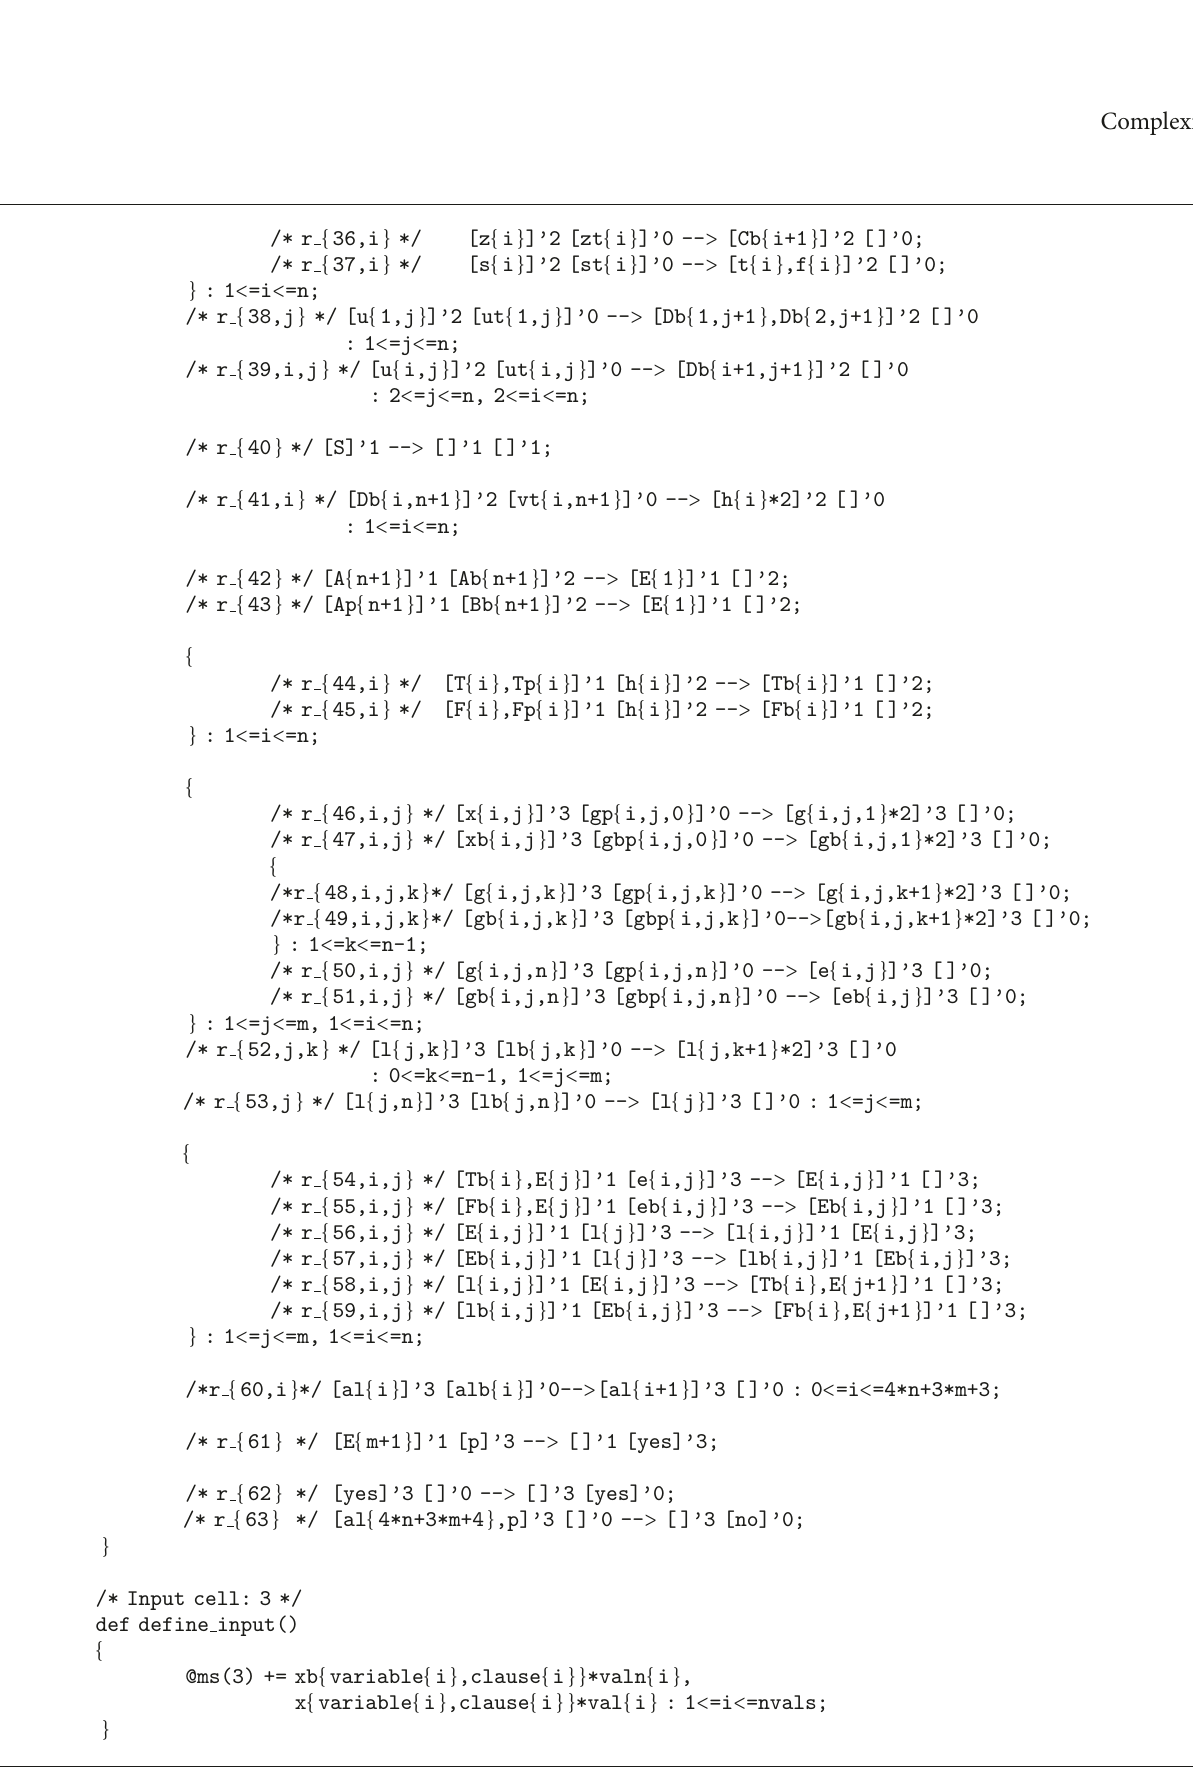
Algorithm 4: P-Lingua translation for SAT